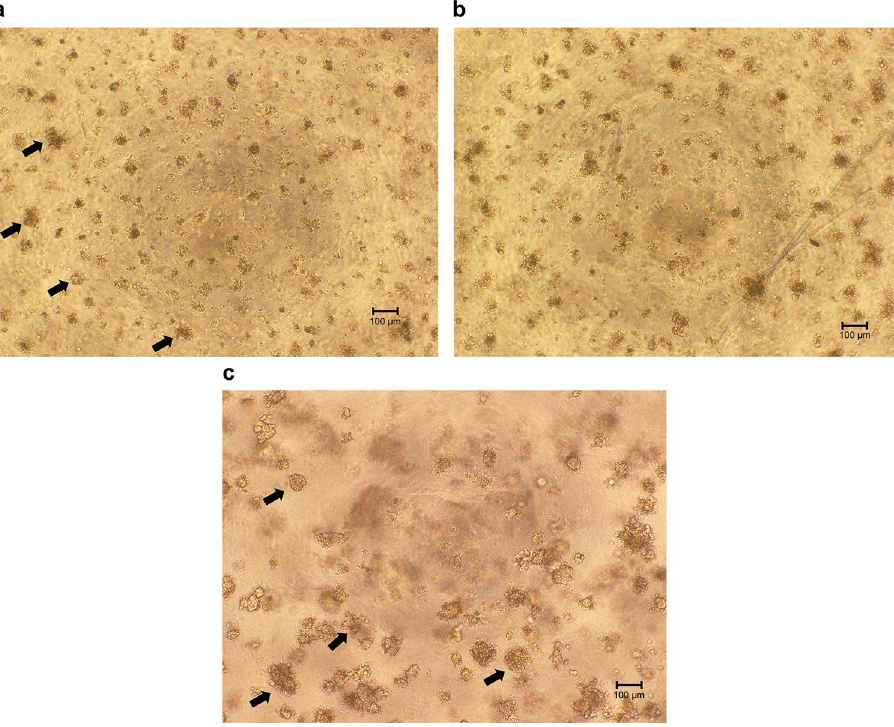
Figure 3. Cells were cultured for 1 week in soft agar during the long-term culture. ( a ) 10 5 MRC-5 cells/ well. Cells aggregated and formed clumps. These are scattered over the entire microscopic field, and some are indicated by arrows. ( b ) 0.1% HeLa cells/well. Colonies of HeLa cells intermingled with clumps of MRC-5 cells but could not be distinguished from each other. ( c ) 10 4 HeLa cells/well. Many colonies were observed in the soft agar medium; some are indicated by